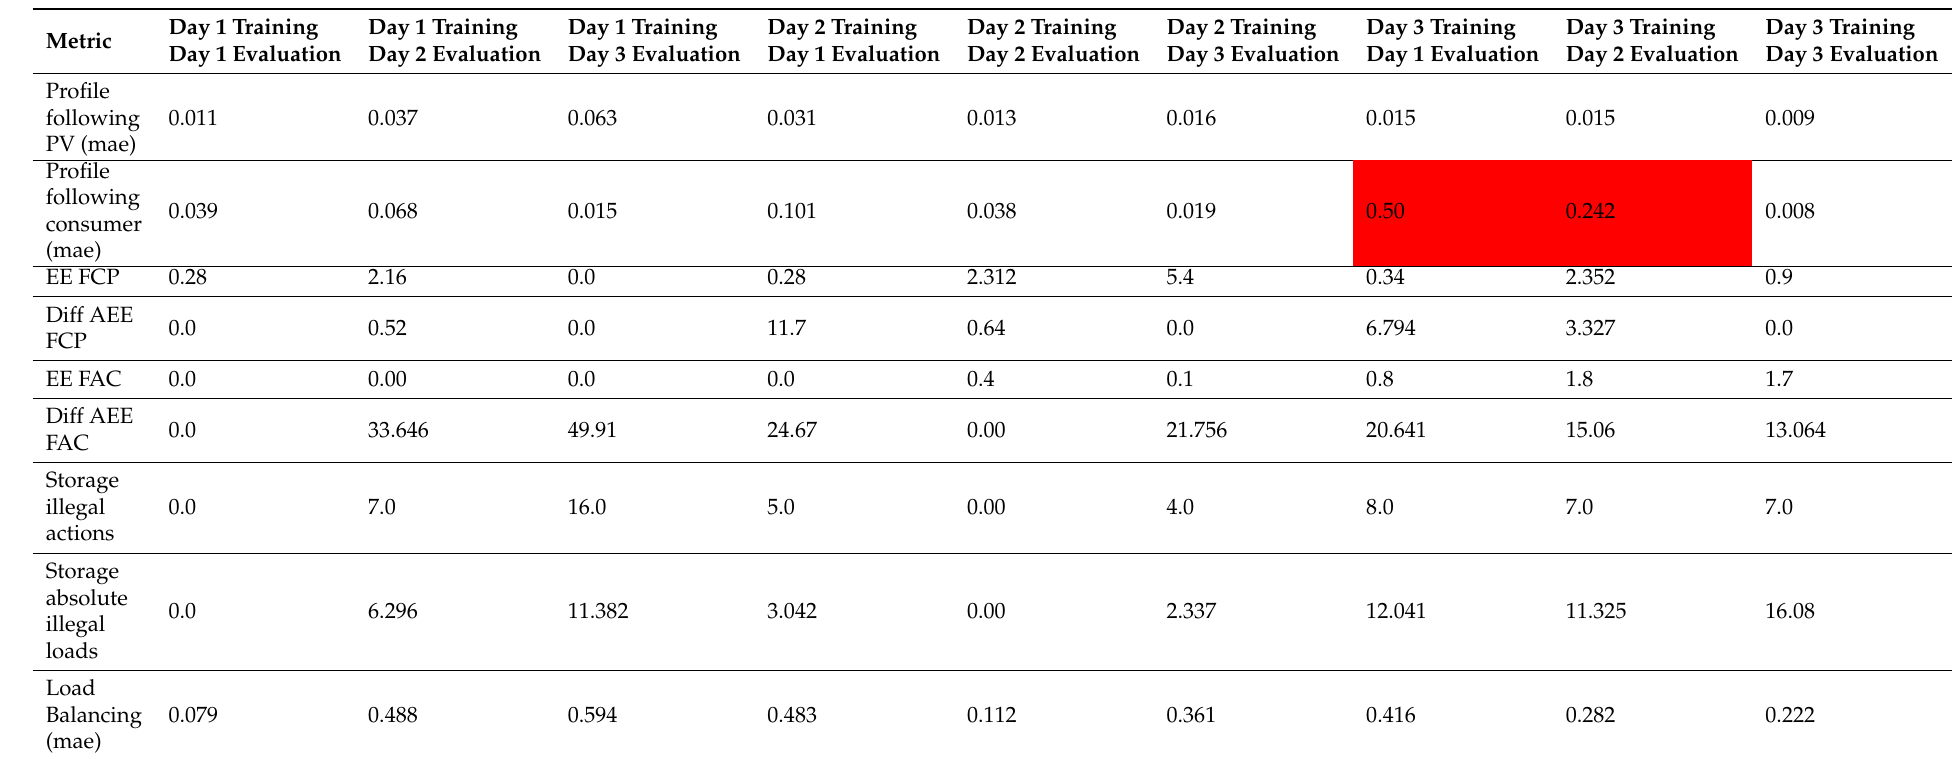
Table 5. Quantitative analysis of trained agents evaluated on different